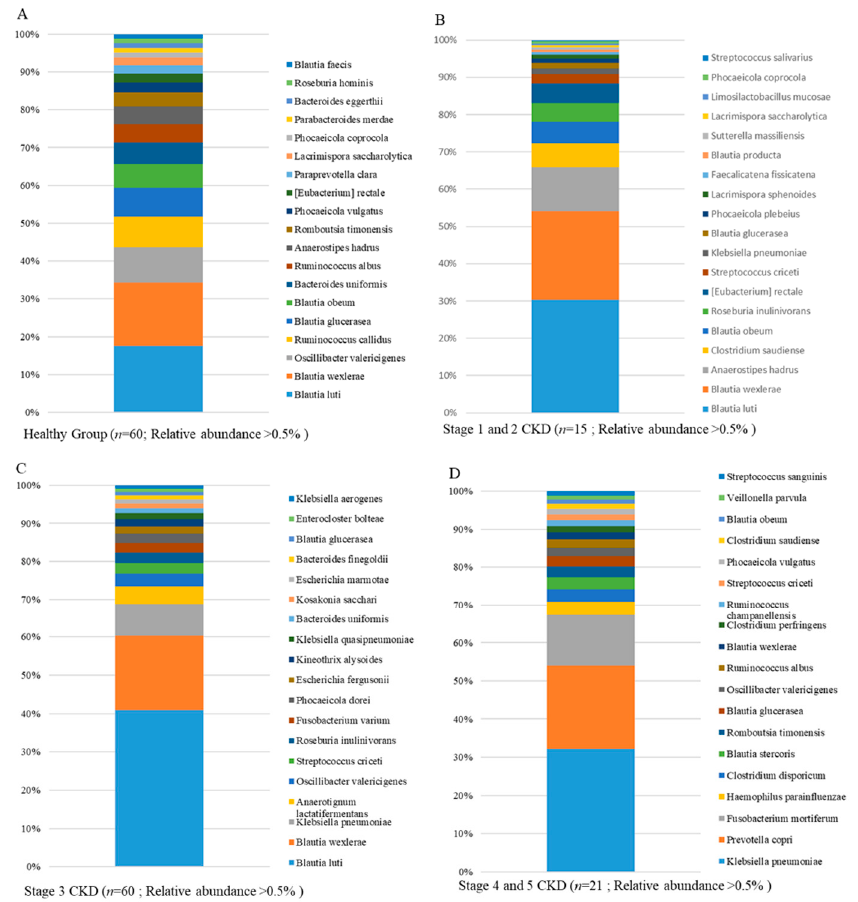
Figure 4. Characterization of identified taxa in healthy participants and chronic kidney disease (CKD) patients with long-read sequencing results. Relative abundances of the top 20 classified operational taxonomic units (OTUs) to species level in ( A ) the healthy group, ( B ) Stage 1 and 2, ( C ) Stage 3, and ( D ) Stage 4 and 5 CKD patients are shown on a stacked bar chart. Abundances of OTUs relative to all microbial communities exceed 0.5%.